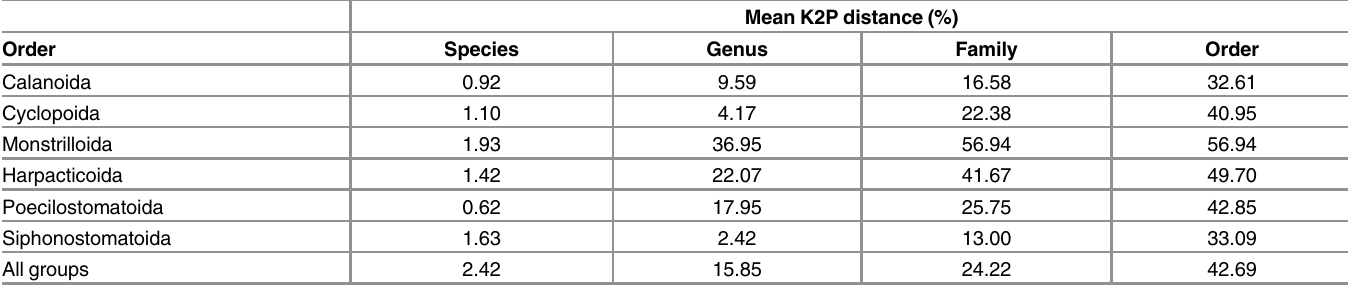
Table 3. Mean genetic divergences at various taxonomic levels (species, genus, family, and order) inferred from nucleotide sequences of COI along the six copepod orders based on the Kimura-2-parameter (K2P) distances.